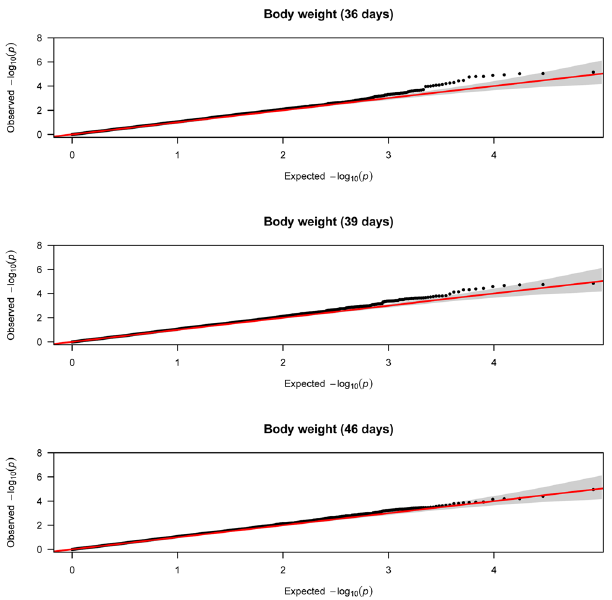
Figure 2. Quantile-quantile plots of body weight traits using mixed linear model